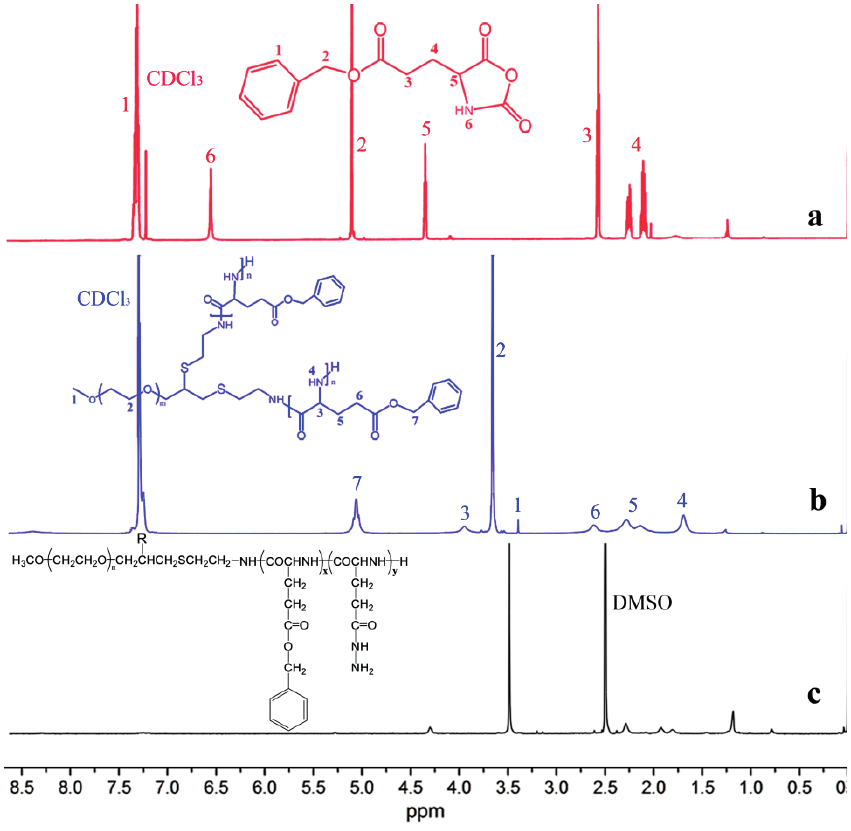
( b ) copolymer in CDCl 2